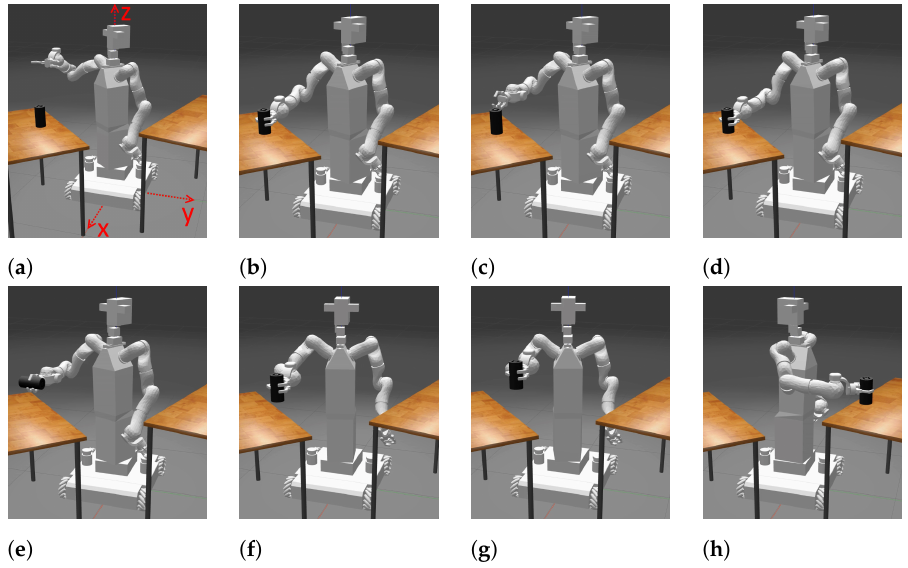
Figure 10. The partial illustration of the test task in simulation: ( a – e ) stage 1, ( f – g ) stage 2, ( h ) stage 3. The test task was repeated two times for a 2 kg object. The first time, the object’s weight was not compensated, so the vector τ ogc from Equation (7) was arbitrarily set to zero, and there was no necessity to perform stage 1 of the task. The second time (https://vimeo.com/ 567801853, accessed on 10 October 2021), the vector τ ogc was computed in every control cycle, parameters (Section 3). The computed weight Equation (13) was w = 19.6024 N, and the mass (cid:2) (cid:3) T centre position vector Equations (14)–(16) was ( k ) r = 0.13065 − 0.01121 − 0.00837